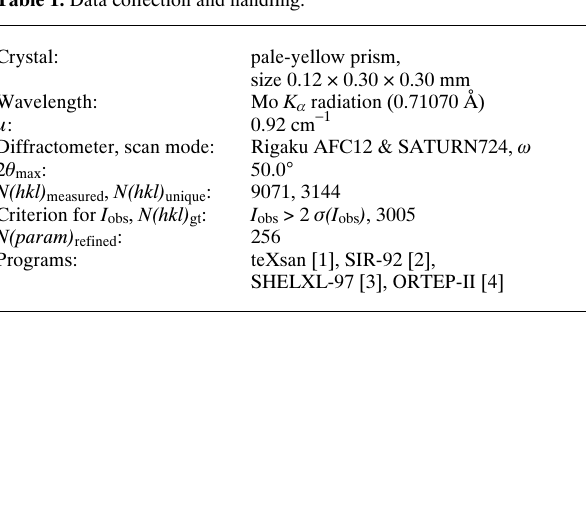
Table 2. Atomic coordinates and displacement parameters (in Å 2 ) . Table 1. Data collection and